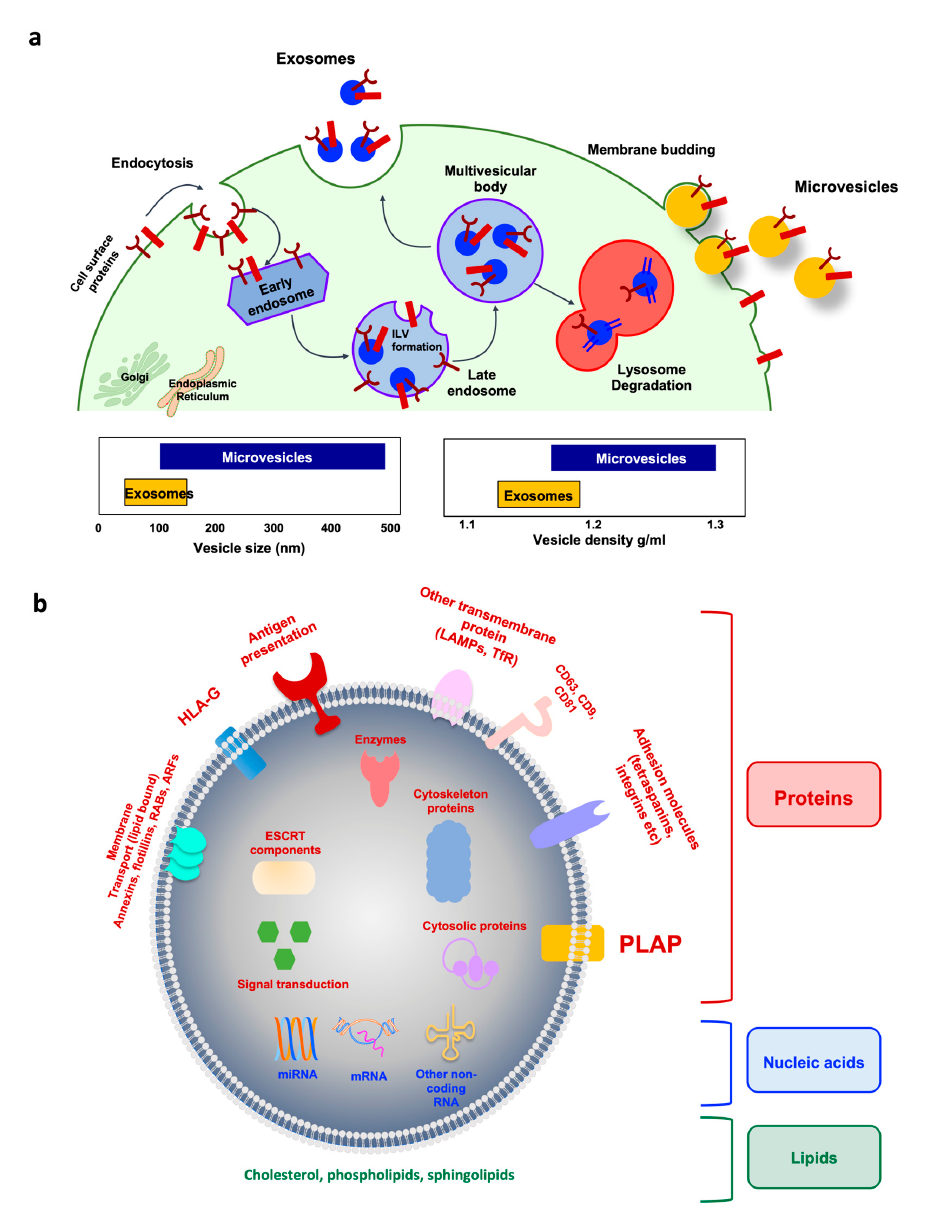
Figure 2. Extracellular vesicle biogenesis and compositions. ( a ) Exosome biogenesis and intracellular life are depicted on the left. Cell surface proteins are endocytosed and trafficked to early endosomes. Once sorted to late endosomes, the endosomal sorting complex required for transport of (ESCRT)-0 complex recruits ubiquitinated proteins, while ESCRT-I and -II mediate the budding of intraluminal vesicles (ILVs). The multivesicular body (MVB) can either follow a degradation pathway fusing with lysosomes or proceed to release the ILV contents (as exosomes) to the extracellular space by an exocytic step. Microvesicle biogenesis via plasma membrane budding is illustrated on the right. Transmembrane proteins are clustered in discrete membrane domains that promote outward membrane budding. Tetraspanins and other proteins abundant at the domain may have a role by promoting the sorting of other components. Lipid-anchored (myristoylation, palmitoylation) proteins accumulate proteins in the lumen as well as contribute to membrane curvature. Additional mechanisms of microvesicle formation include the calcium-activated scramblases, which randomize the distribution of lipids between the two faces of the plasma membrane. The cytoskeleton becomes looser, while cytosolic proteins and RNA molecules are sorted into microvesicles. The specific ATPase VPS4 mediates the disassembly of the spiral by pulling its end. ( b ) Representative